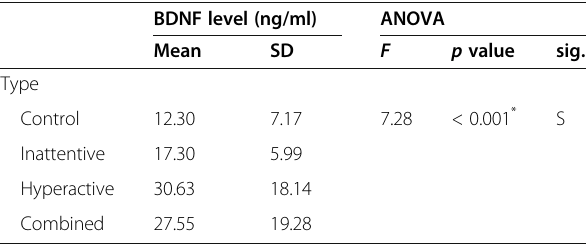
Table 4 Comparison between plasma BDNF among control group and ADHD group; its clinical subtypes